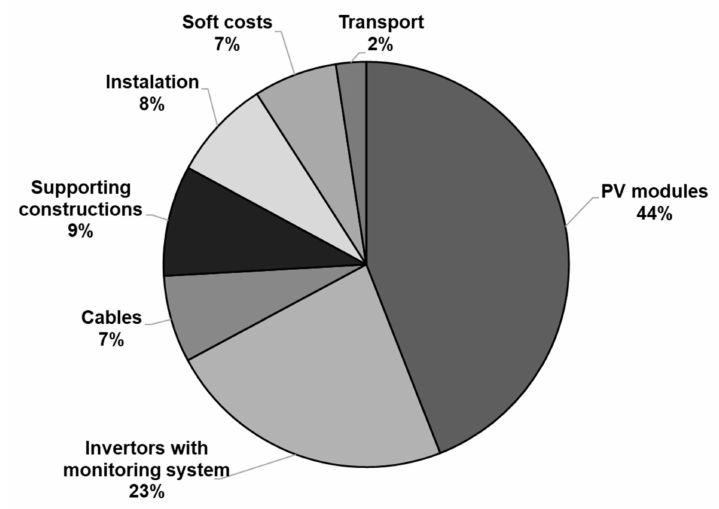
Figure 2. Typical division of costs for 500 kW p commercial roof system within the Czech Republic installed on own